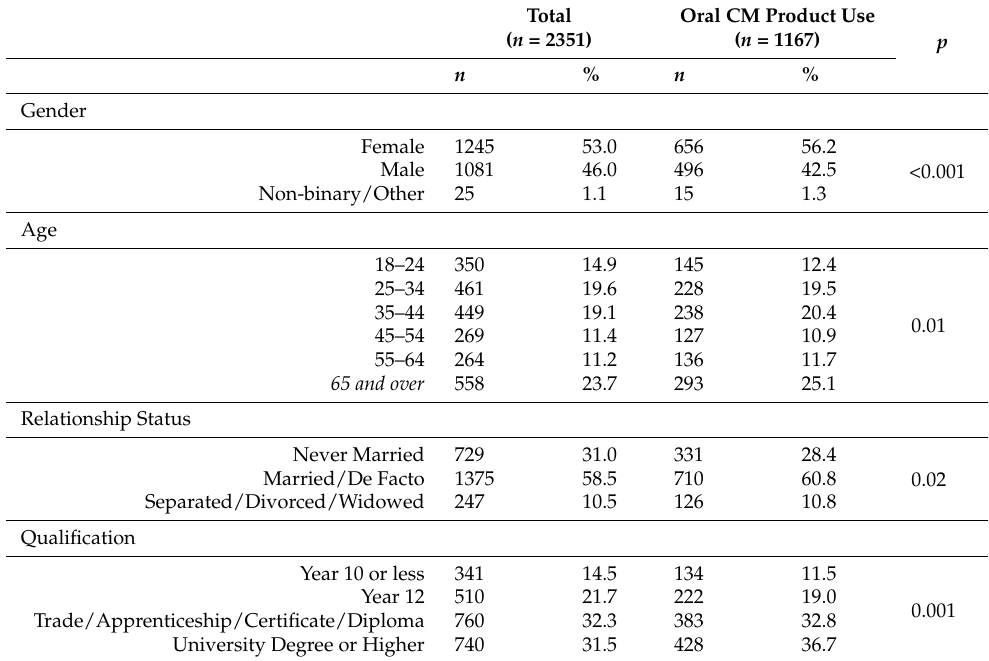
Table 2. Association between participant demographic characteristics and use of oral CM